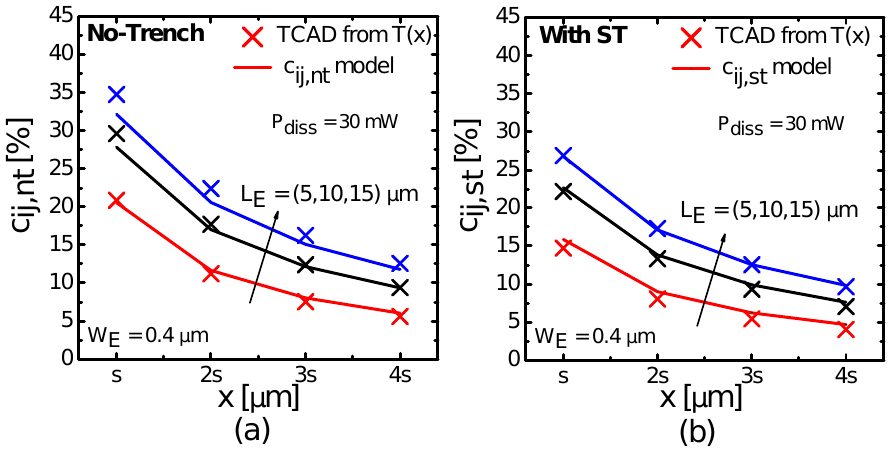
Figure 4. A comparison between the TCAD results and the proposed model of ( a ) c ij , nt and ( b ) c ij , st for devices with different L E at a fixed W E = 0.4 µ m and P diss = 30 mW.